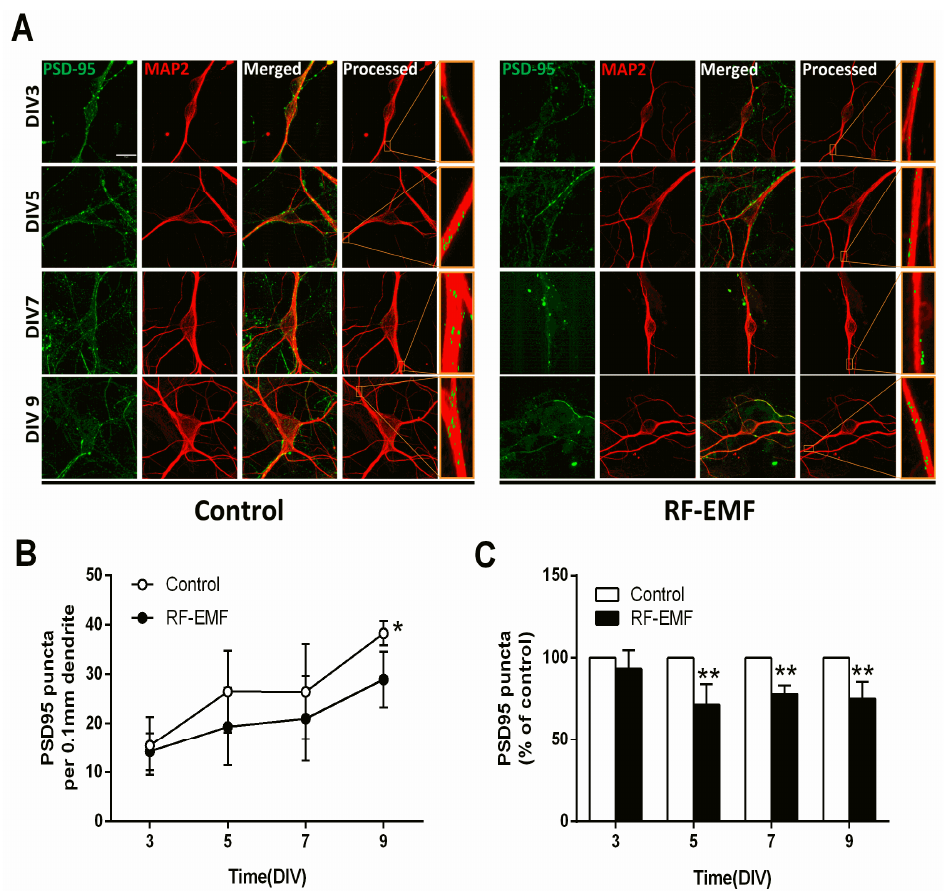
Figure 4. Exposure to RF-EMF decreased synaptic densities in mouse hippocampal neurons. ( A ). Confocal images show hippocampal neurons expressing PSD95 (green) and MAP2 (red). Images of PSD95 and MAP2 were analyzed using ImageJ. ( B ). Time-dependent changes in PSD95-positive punctae in dendrites of mouse hippocampal neurons. ( C ). Summary of the changes in PSD95 punctae as a percentage of control. Data are expressed as means ± SD. Statistical significance was evaluated using either ANOVA ( B ) or Student’s t -test ( C ). * p < 0.05, ** p < 0.01 vs. control (control n = 20 mice, RF-EMF n = 16 mice). Scale bars = 15 μm.